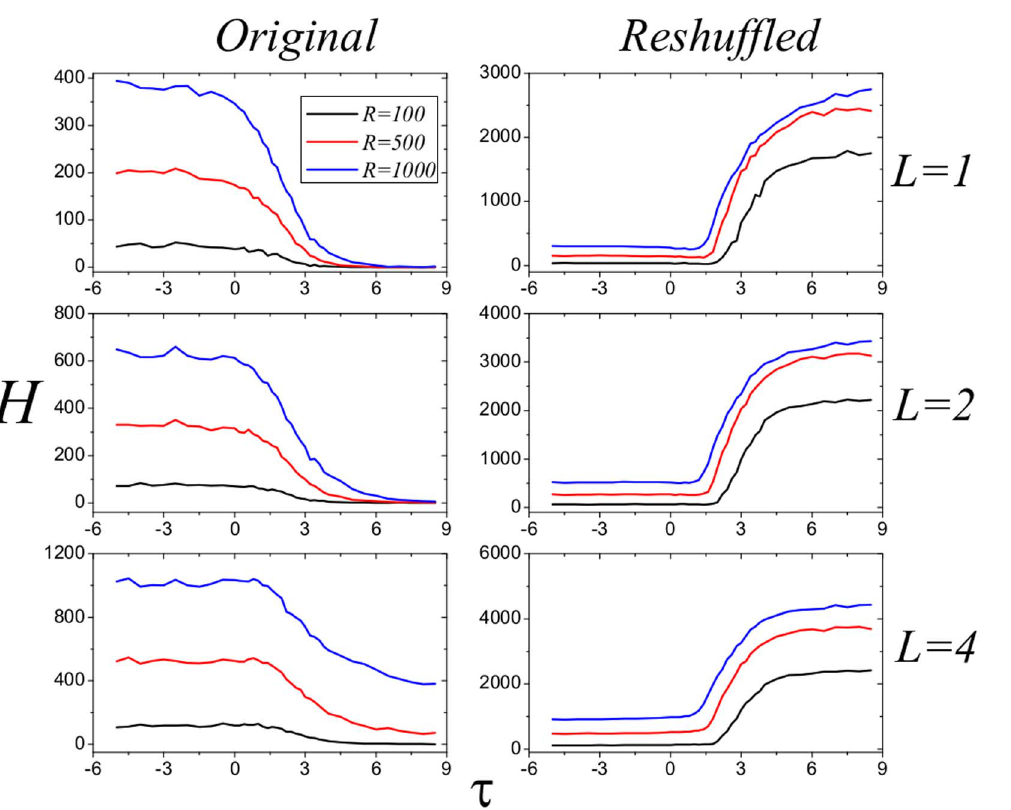
Figure 6. Performance of strategies with different t on original and reshuffled Coo8 networks. The black, red and blue lines represent the results for the cases R ~ 100 , R ~ 500 and R ~ 1000 , respectively. Data points are obtained by averaging over 100 independent